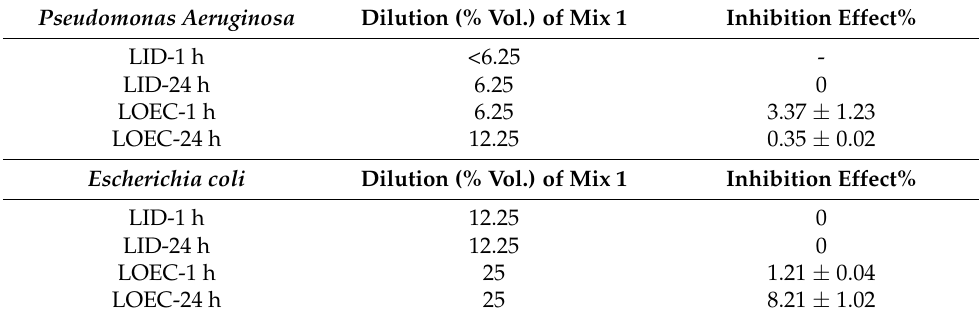
Table 1. LID and LOEC estimations for Mix 1.